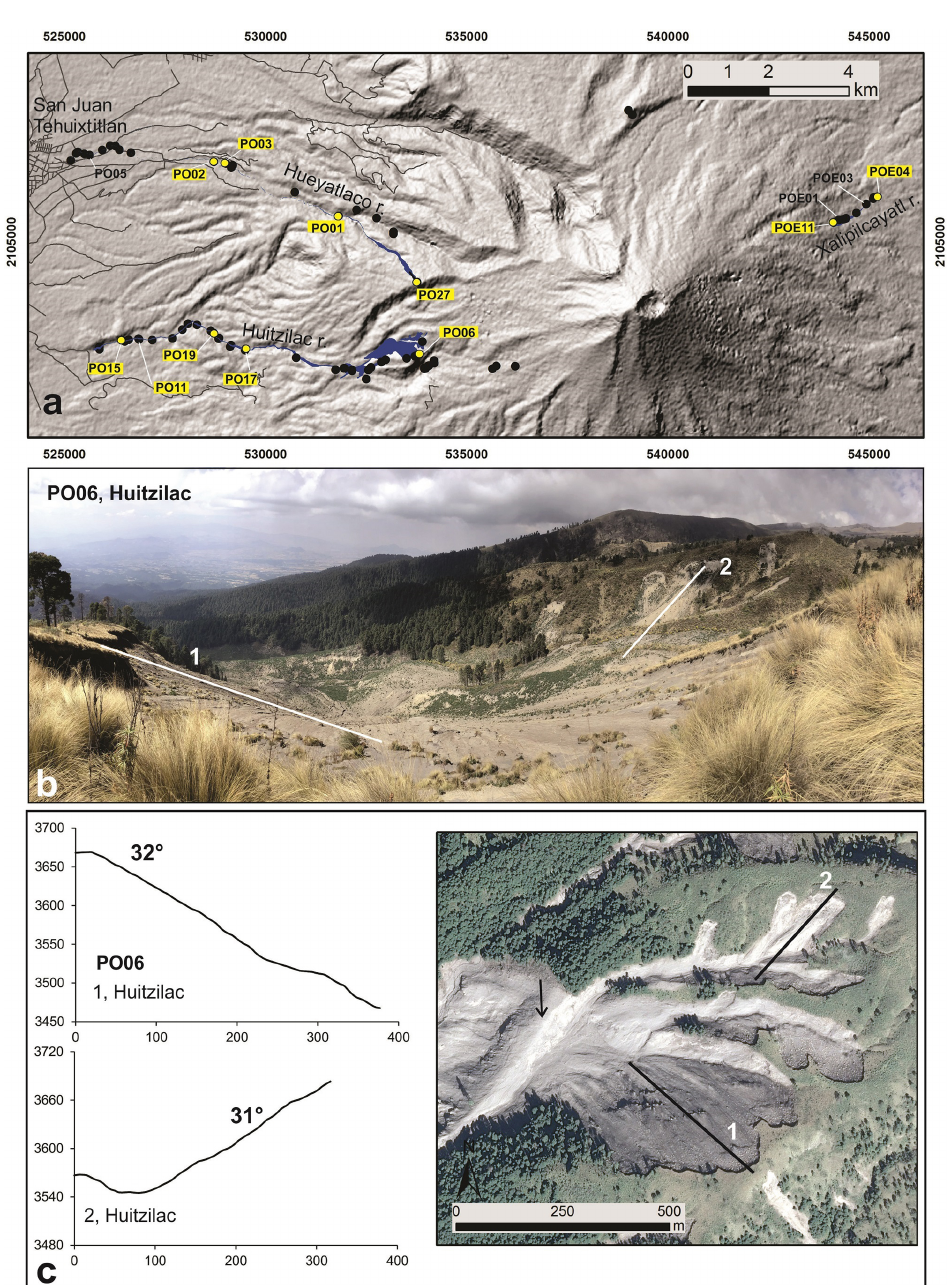
Figure 4. (a) Map of three ravines of Popocatépetl Volcano affected by the debris flows; black dots indicate locations of field surveys (background: 12.5m DEM © JAXA/METI ALOS PALSAR 2008; coordinate system WGS84 UTM Zone 14Q). (b) View in the downstream direction from the top of the sampling point PO06, located on the scarp of the Huitzilac landslide. (c) Topographic profiles of the larger landslides (1 and 2) that occurred at Huitzilac, which are also reported on the Pléiades 1A image acquired on 13 November 2017; the black arrow indicates the topographic barrier overtopped by the debris